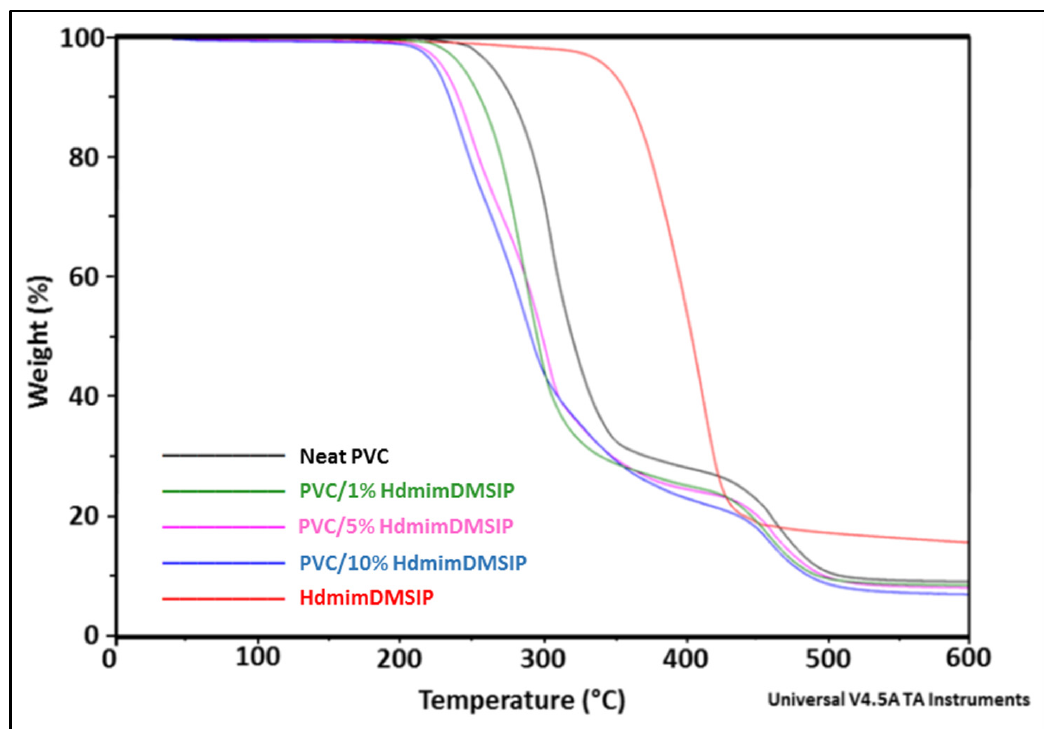
Polymers 2023 , 15 , x FOR PEER REVIEW 12 of 33 Figure 3. TGA curves of the IL HdmimDMSIP, neat PVC, and PVC/IL blends. Figure 3. TGA curves of the IL HdmimDMSIP, neat PVC, and PVC/IL blends.